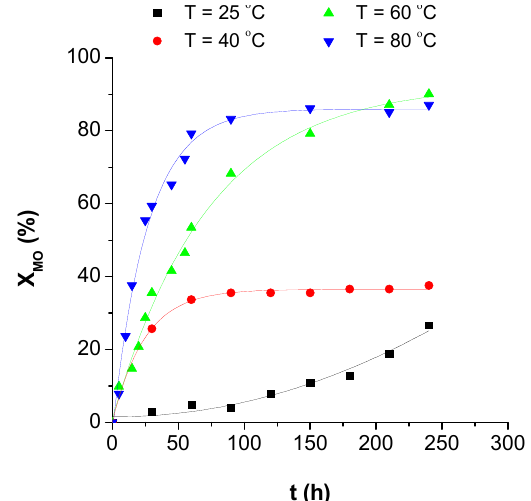
Figure 12. Methyl Orange (MO) decolorization during CWPO using gold supported on titanium nanotubes as catalyst, at different temperatures. Lines were added merely to better illustrate the data trends ([MO] initial = 50 mg/L, [H 2 O 2 ] initial = 0.15 M, [catalyst] = 2.0 g/L and pH initial = 3.0). Adapted from Drašinac et al. [107].